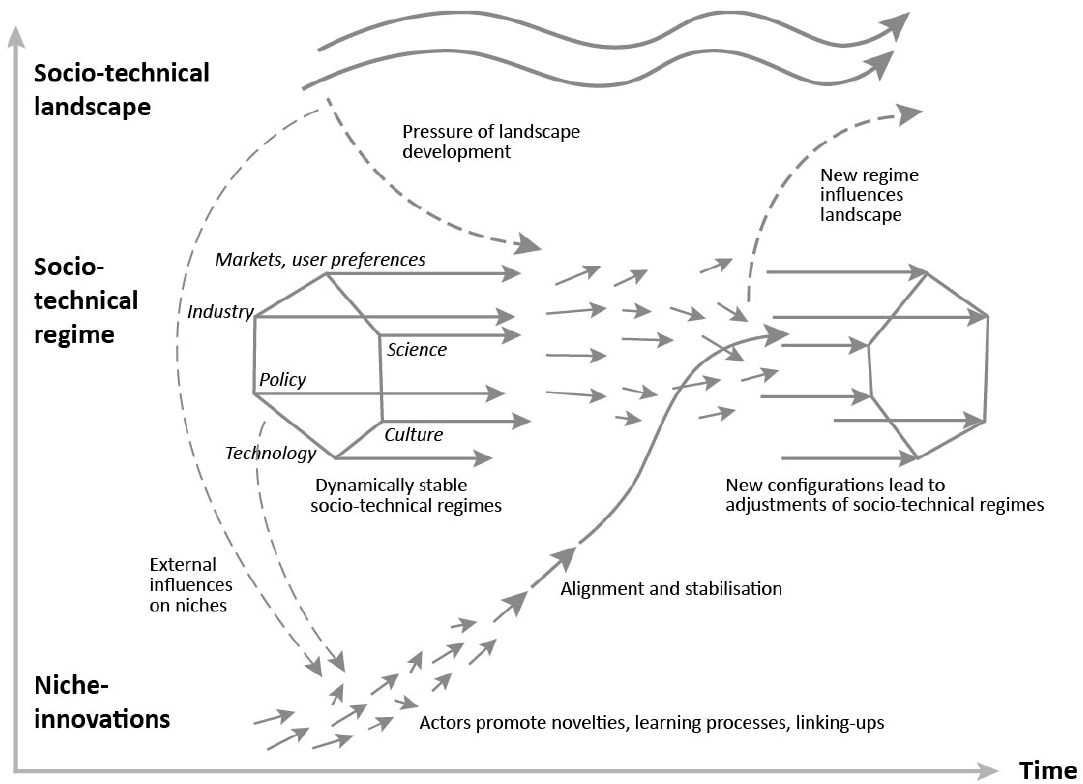
Figure 4. The multi-level perspective on transitions. Adapted from Schot and Geels [44].